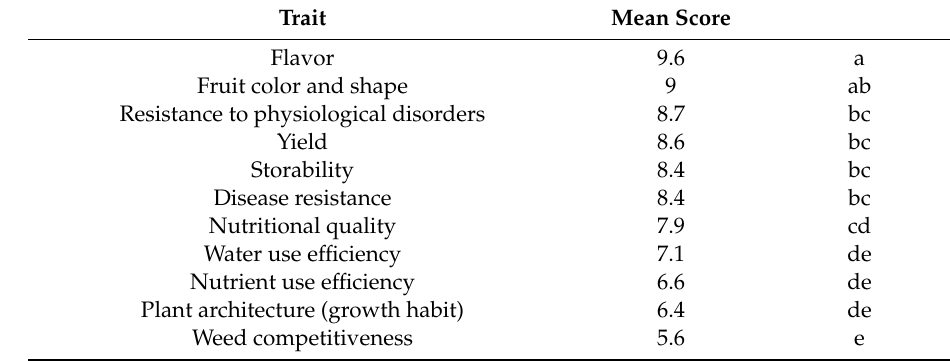
Table 2. Mean scores for the importance of traits to be included in the tomato breeding program in the survey completed by farmers (n = 15). Scale ranging from 0 = not important at all to 10 = very important. Di ff erent letters indicate significant di ff erences (Student-Newman-Keuls test, at p < 0.05). Trait Mean Score Flavor 9.6 a Fruit color and shape 9